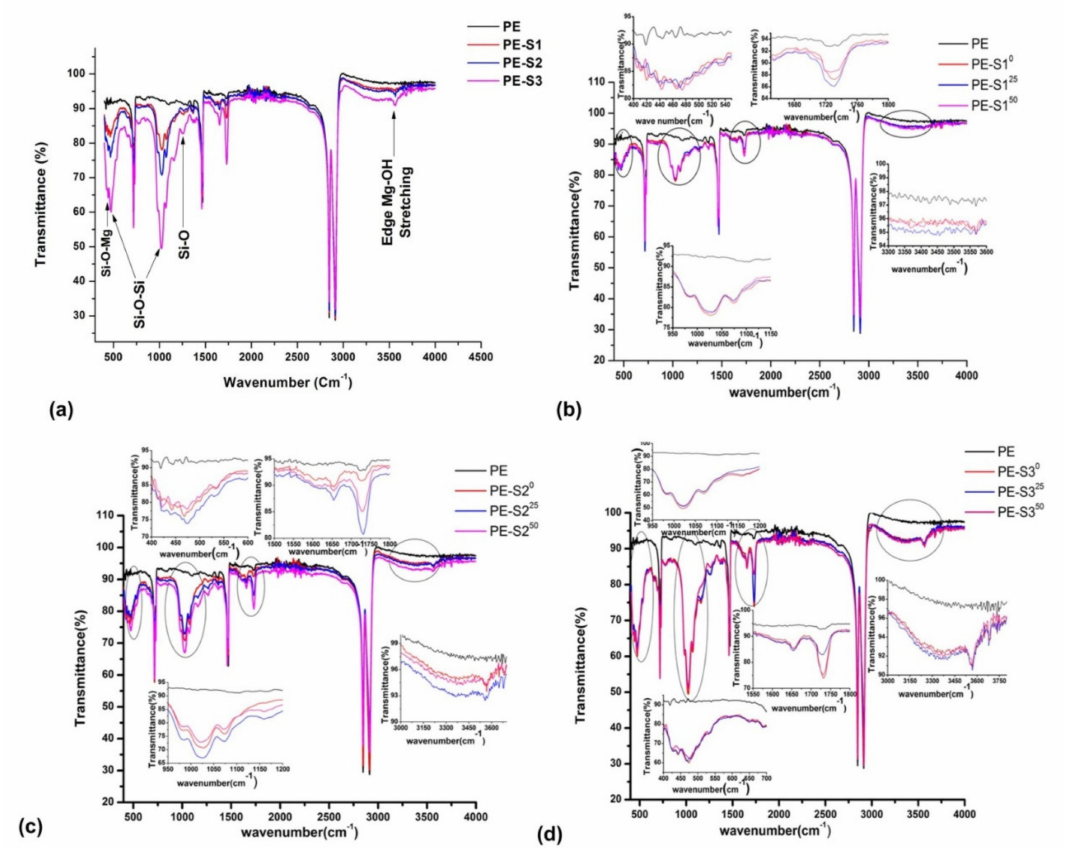
Figure 2. FTIR spectra of ( a ) unirradiated UHMWPE and UHMWPE/SP composites with ( b ) 1% of SP concentration, ( c ) 2% of SP concentration, and ( d ) 3% of SP